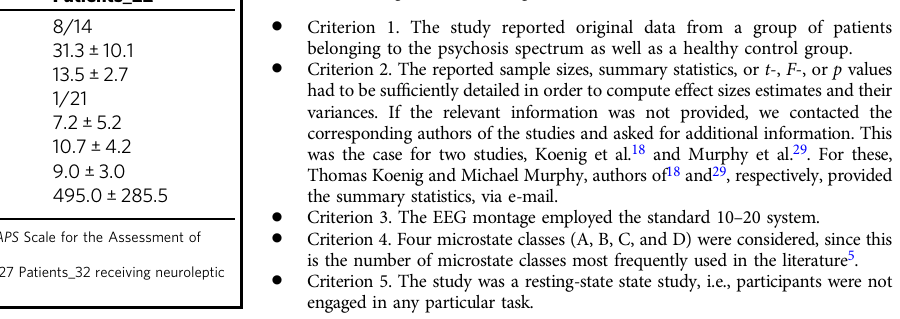
four microstates for each group, and labeled them A – D according to their similarities to the previously reported microstate classes 5 . To ensure that the four selected microstates were similar across groups, we computed spatial correlation 53 for each of the four microstate classes for each pair of groups. High spatial correlation coef fi cients indicated that the microstate classes were similar between groups (see Supplementary Tables 1 and 8). Subsequently, for each group, we compared the four microstates with the instantaneous scalp potential maps in each participant ’ s artifact-correct EEG using a competitive fi tting procedure. For each time point of the individual EEG, the scalp topography was compared with each microstate class using spatial correlation. The time point was then labeled according to the microstate that exhibited the greatest correlation. Temporal smoothing (window (half) size = 5, strength (Besag) = 10, rejection of microstates with durations of one time frame) was applied to ensure that noise during low GFP periods did not interrupt segments of quasi-stable topographies 10 . For each subject, three per class microstate parameters were computed: mean duration, time coverage, and frequency of occurrence (occurrence). Mean duration (in ms) is the average time that a given microstate was uninterruptedly present. Time coverage (in %) is the percentage of the total analysis time spent in a given microstate. Occurrence is the mean number of times a given microstate is occurring per second. Microstates analysis was performed using Cartool 24 (version 3.70). The temporal smoothing in the current study was different from the one performed by Tomescu et al. 6 , a study with data from 27 patients and 27 controls included in our sample. As mentioned above, in the current study, we rejected microstates with durations of one time frame, while Tomescu et al. did not. This resulted in the microstate mean durations in the current study to be longer than the ones reported by Tomescu et al. However, in a subsequent work from the same group of researchers 41 , rejection of microstates with durations of one time frame was applied, which led to microstate mean durations similar to the ones in current study.